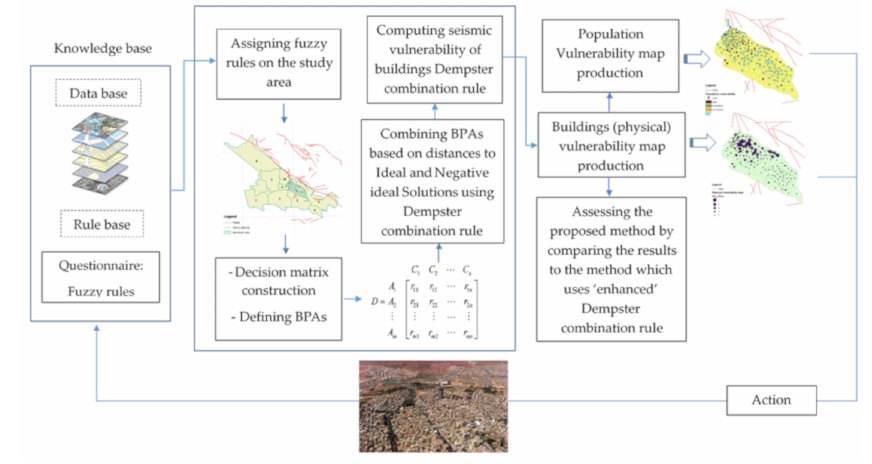
Figure 3. The flowchart of the proposed